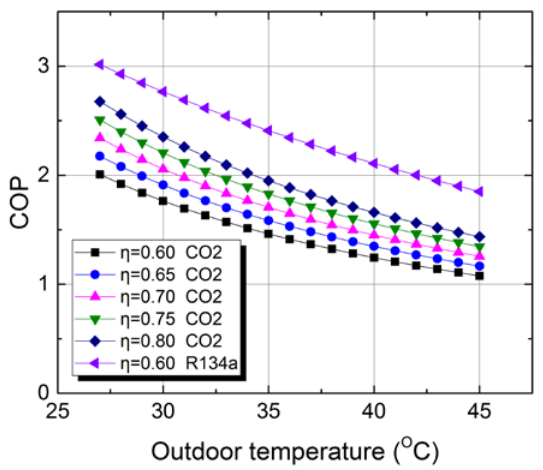
Figure 9. Effect of compressor overall efficiency on the COP of the CO 2 system.